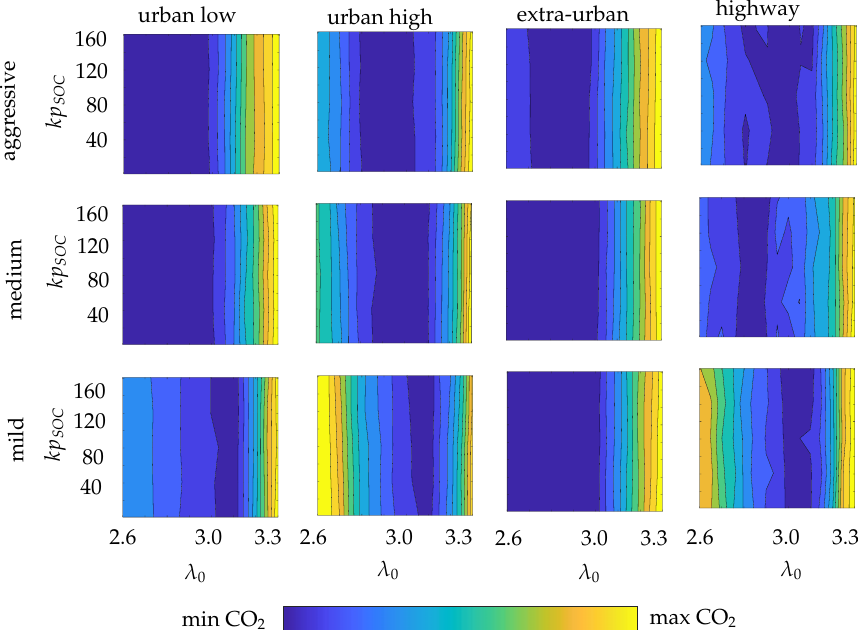
Figure 6. Parameter studies for both kp SOC and λ 0 for Online ECMS (25 Wh battery).